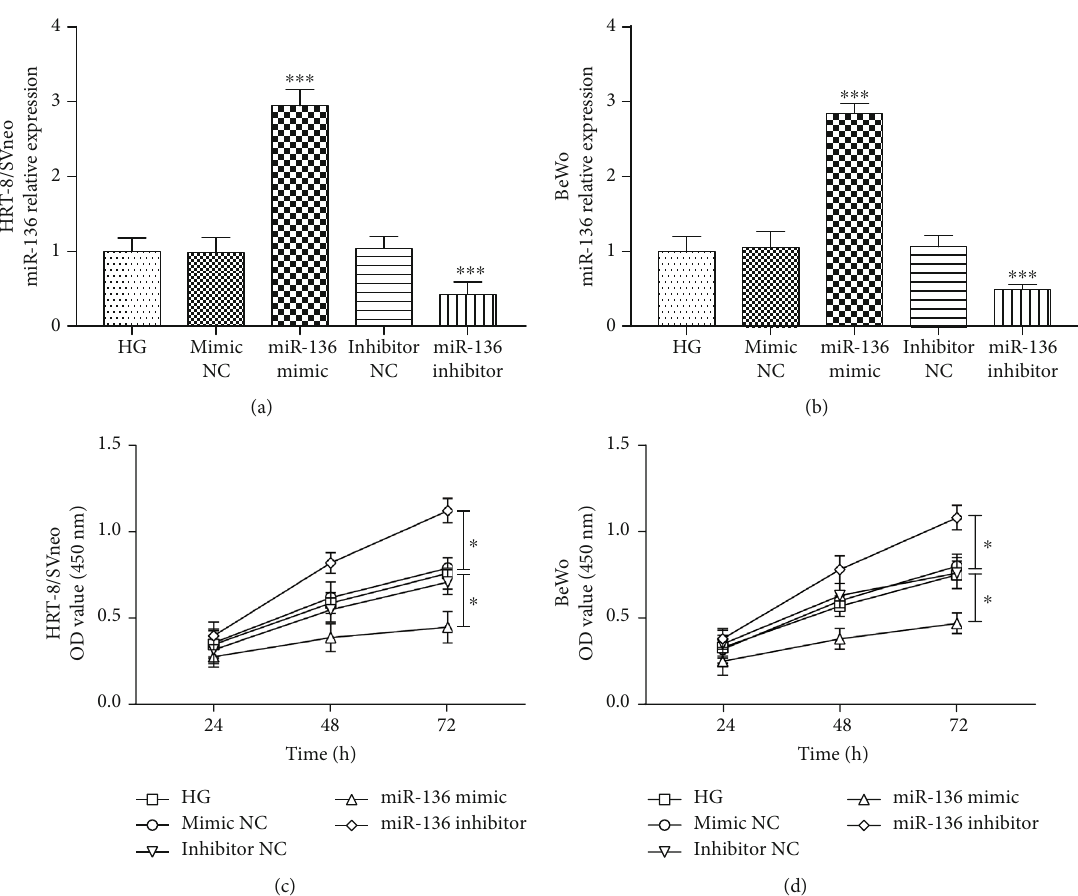
Figure 3: Reverse e ff ect of miR-136 silencing on the impaired trophoblast cell viability resulted from high glucose in HRT-8/SVneo and BeWo cells. (a, b) miR-136 mimic increased, while miR-136 inhibitor inhibited the expression of miR-136 in trophoblast cells ( ∗∗∗ P < 0 : 001 ). (c, d) The inhibiting e ff ect of high glucose on trophoblast cell proliferation was enhanced by the overexpression of miR- 136, but was reversed by the knockdown of miR-136 ( ∗ P < 0 : 05 ). HG: high